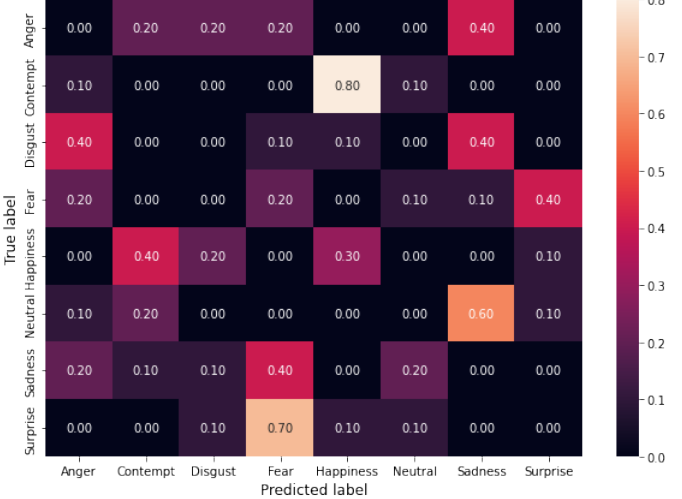
Figure 1. Confusion matrix from the results of the attack with three filters.